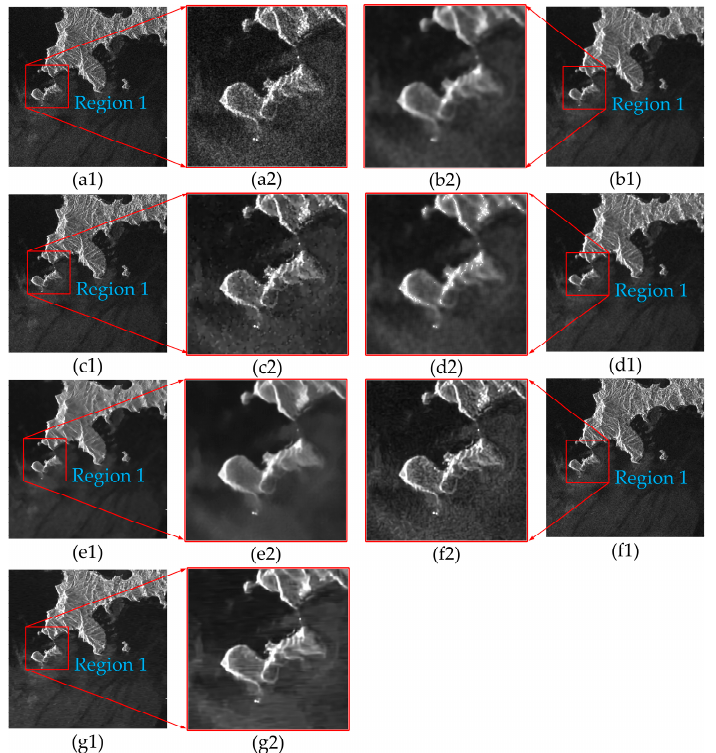
Figure 8. ( a1 ) Noisy Sentinel-1 SAR image. Filtered images by the ( b1 ) SRAD filter, ( c1 ) DPAD filter, ( d1 ) EnLee filter, ( e1 ) PPB filter, ( f1 ) SAR-BM3-D filter, and ( g1 ) FANS filter. ( a2 – g2 ) are the enlarged images of region 1 from ( a1 – g1 ). Remote Sens. 2023 , 15 , x FOR PEER REVIEW Table 5. Index evaluation of the Sentinel-1 SAR image.